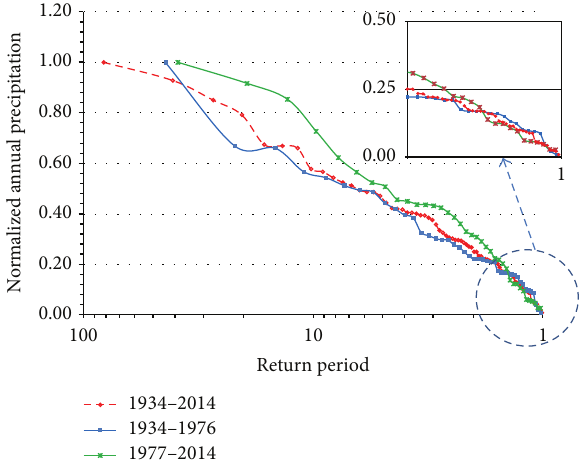
Figure8:Comparisonofrainfallfrequency(returnperiod)interms of normalized annual rainfall events.